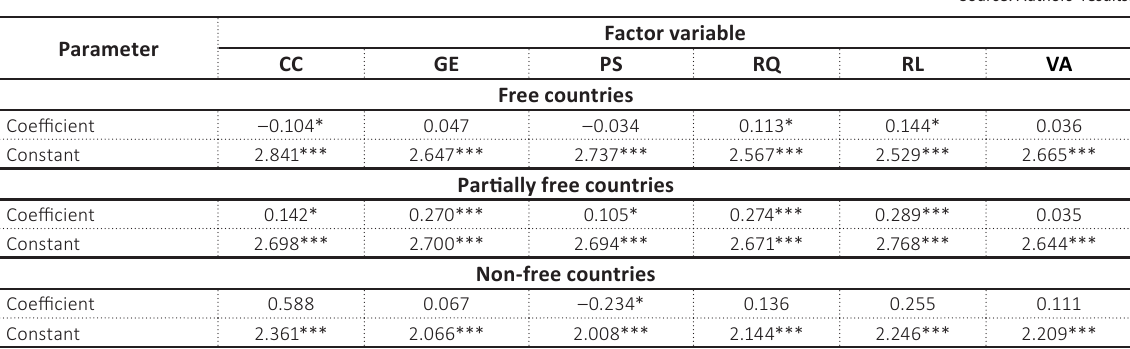
Table 5. The influence of governance quality on the level of independence of central banks among the countries with different levels of civil